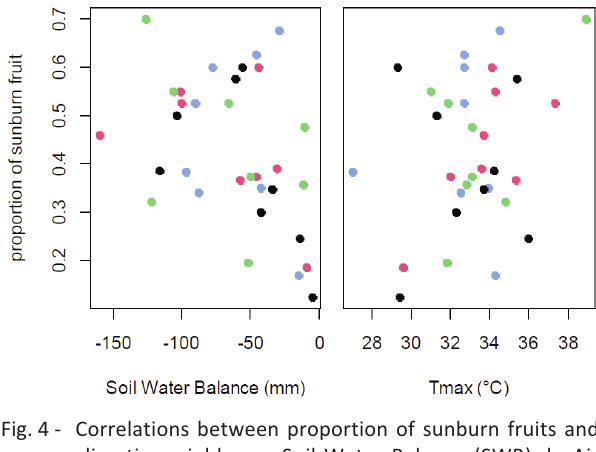
Fig. 4 ­ Correlations between proportion of sunburn fruits and climatic variables. a. Soil Water Balance (SWB); b. Air maximum temperature (Tmax). Colors represent each cycle: black for cycle 1, red for cycle 2, green for cycle